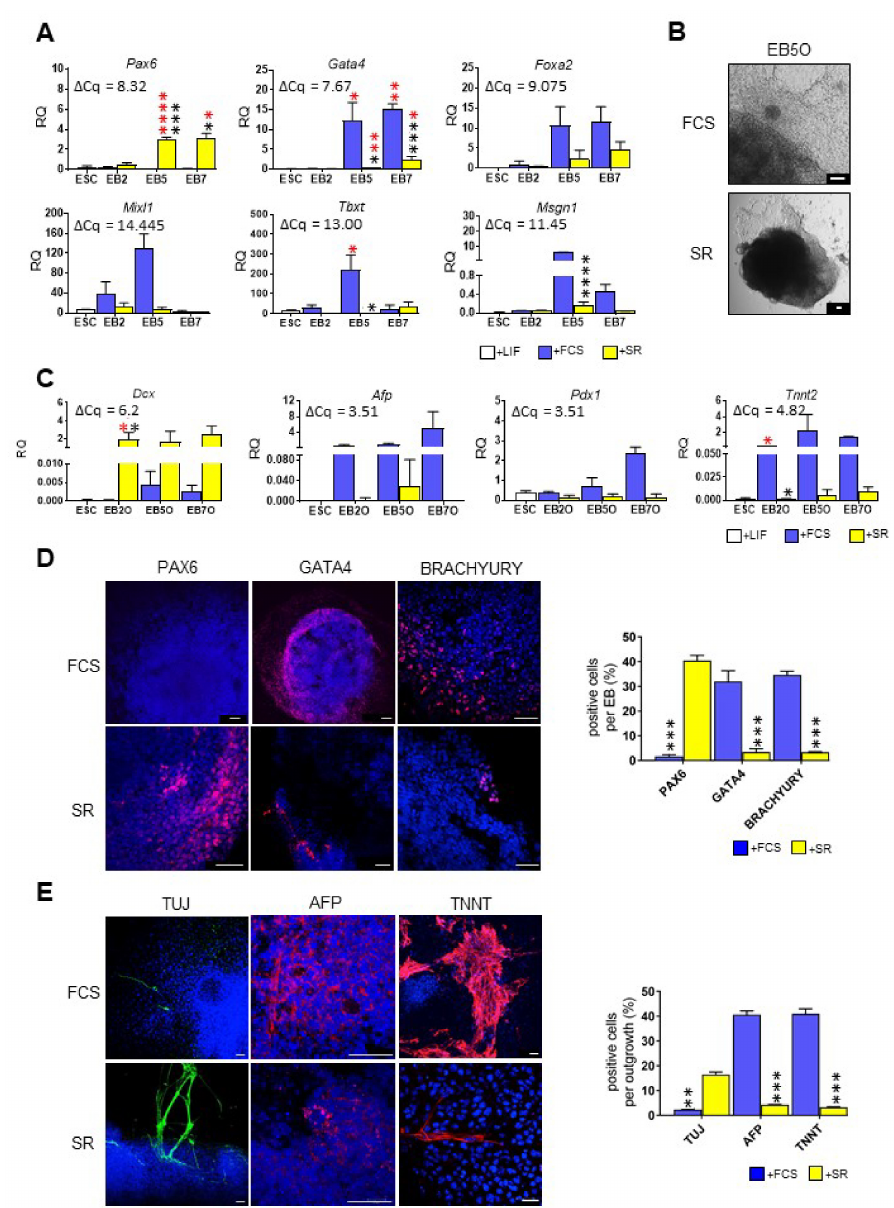
Figure 2. Analysis of differentiation marker expression in undifferentiated ESCs, EBs and EBOs cultured in medium supplemented either with FCS or SR. ( A ) Expression of germ layer markers: Pax6 , Gata4 , Foxa2 , Mixl1 , Tbxt , Msgn1 . ( B ) Morphology of EBOs derived from EB5. Scale bar: 100 µ m. ( C ) Expression of selected cell type markers: Dcx , Afp , Pdx1 , Tnnt2 . ( D ) Representative images of PAX6, GATA4, and BRACHYURY immunostaining in EB5. Scale bar: 50 µ m. Analyzed proteins are shown in red; DNA in blue. The graph shows the mean proportion of cells expressing indicated proteins in EBs. ( E ) Representative images of TUJ, AFP, and TNNT immunostaining in EB5O. Analyzed proteins are shown in green (TUJ) or red (AFP and TNNT); DNA in blue. Scale bar: 50 µ m. The graph shows the mean proportion of cells expressing indicated proteins in outgrowth. For the qPCR analyses ( A , C ) β -actin served as a reference gene. RQ = 1 for the expression level detected in a 13.5-day-old mouse embryo. The average ∆ Cq for reference sample is shown on each graph. Data presented as means of three independent experiments with standard deviations; * p <